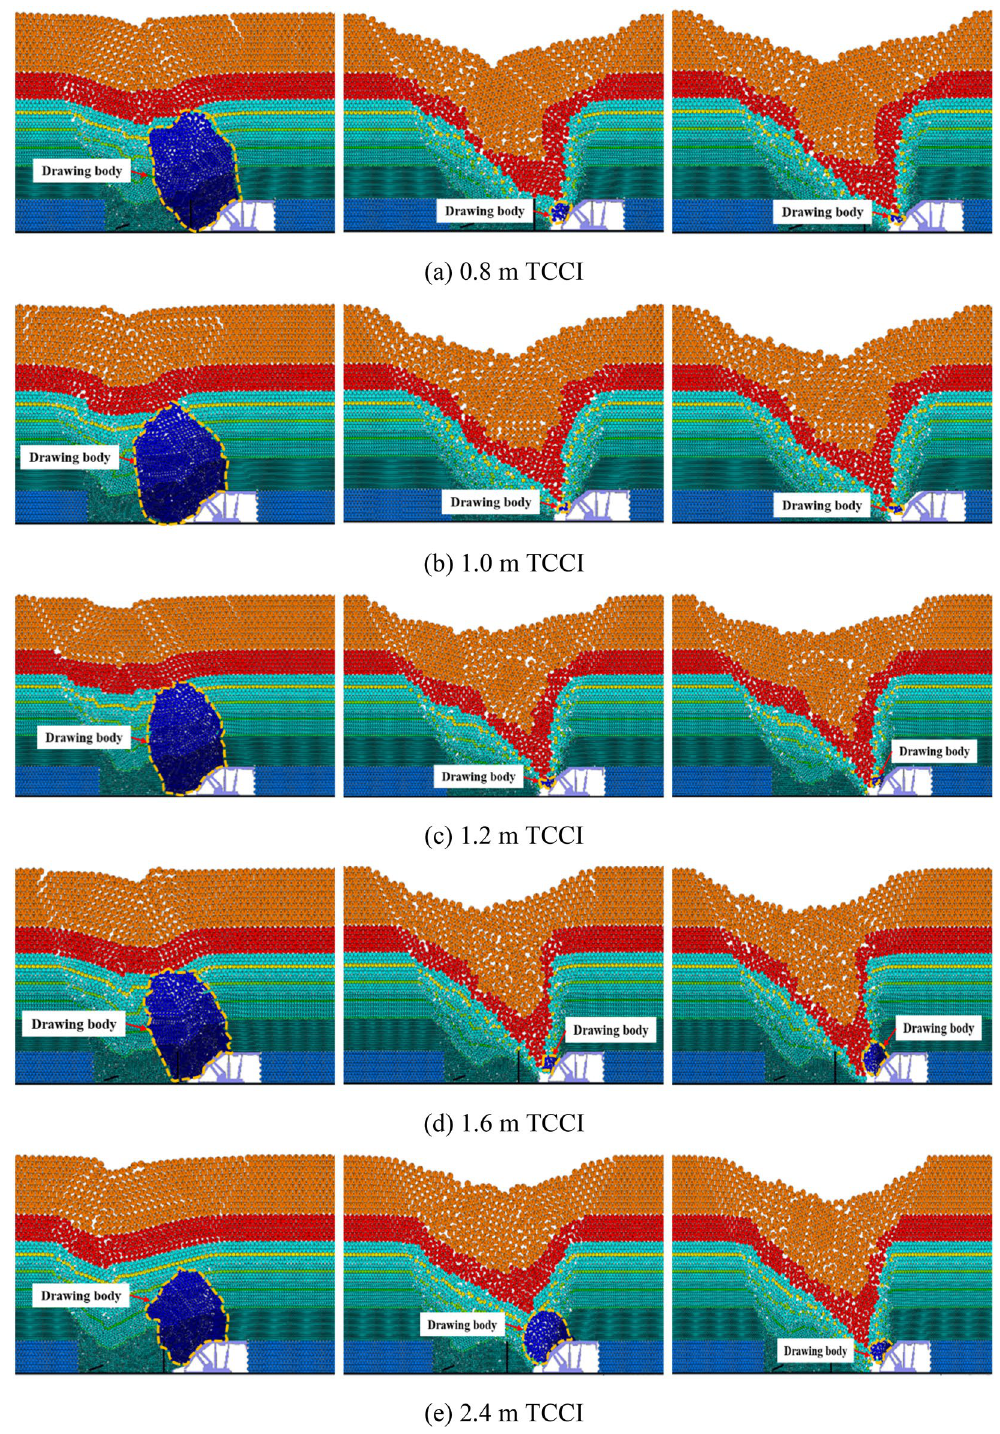
Figure 5. Inversion results of the first three top coal release body in different coal-drawing interval under 12.0 m top coal